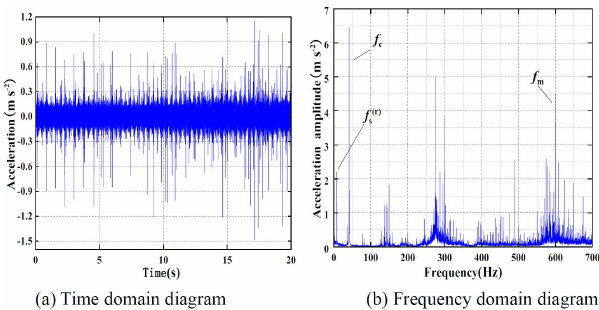
Figure 13. Vibration acceleration signal of the gearbox at n = 2500rpm.